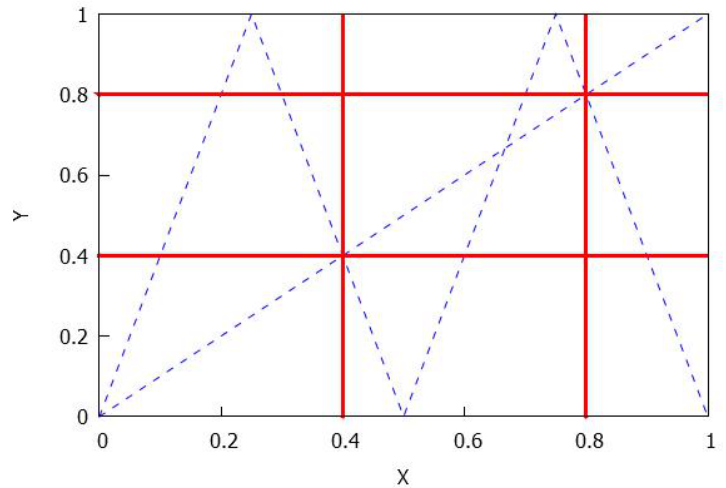
Figure 34. In red, the connected ω -limit set ω F ( x 0 , y 0 ) for a periodic point y 0 of period 2. According to the aspect of the drawn ω -limit sets of a Cournot map with non-empty interior, we are left the following result concerning the connectivity of such a ω -limit